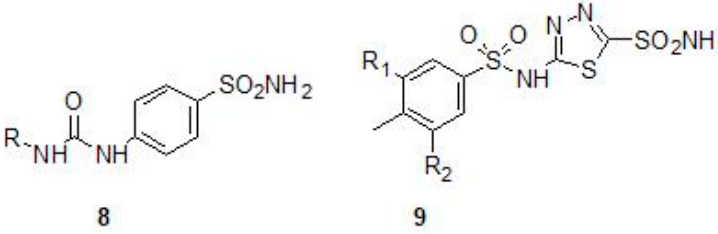
Figure 4. General chemical structures of ureido containing sulfonamides ( 8 ) and halogenated benzene sulfonamides ( 9 ).